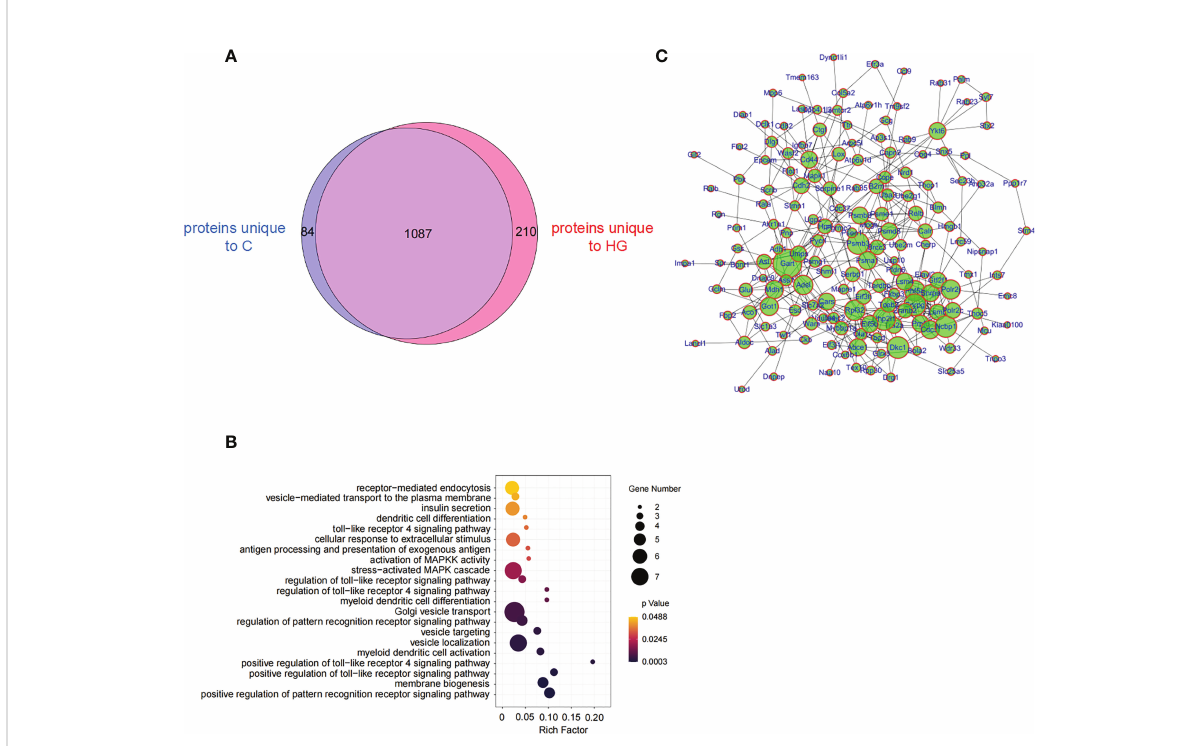
FIGURE 4 High-glucose treatment reshape the proteome of NIT-1 cell-derived sEVs (A) Venn diagram of proteins identi fi ed from high-glucose treated (HG) or untreated (C) NIT-1 cell. (B) GO analysis of 210 unique proteins in high-glucose treated NIT-1 cells. (C) A protein-protein interaction (PPI) network of unique proteins derived from high glucose treated NIT-1 cells